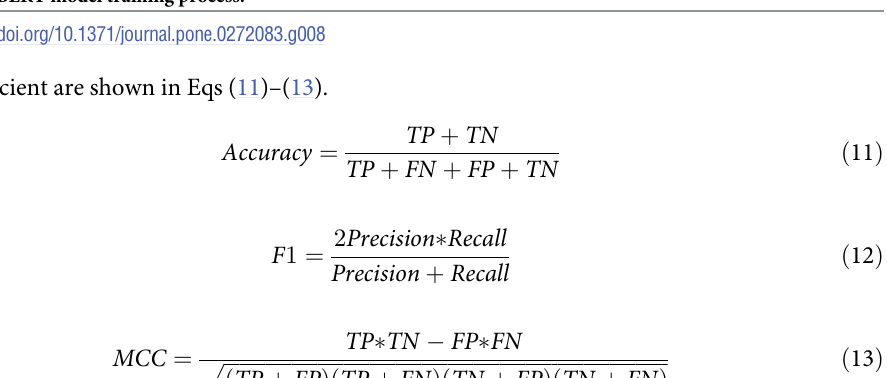
Fig 8. BERT model training process.